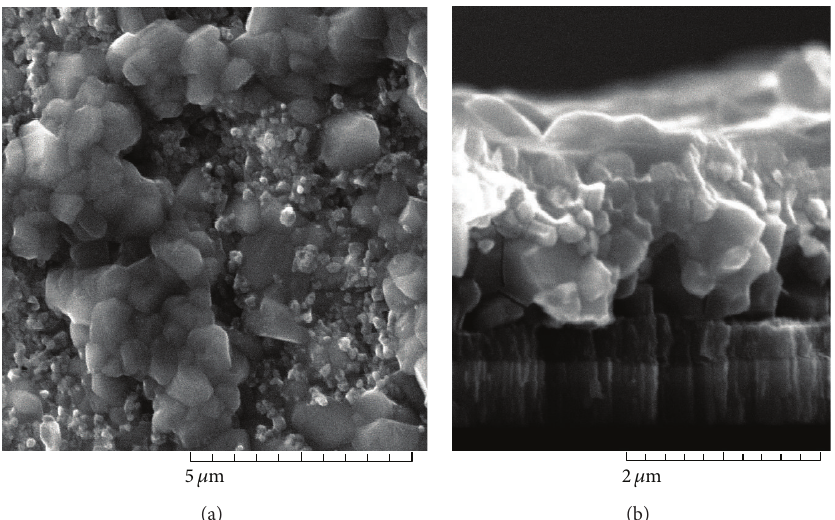
Figure 1: SEM micrographs of the Cu-poor/Zn-rich CZTS layers examined in this work after the etching procedure in aqueous HCl (300 sec at 75 ∘ C): (a) plan view; (b) cross section.